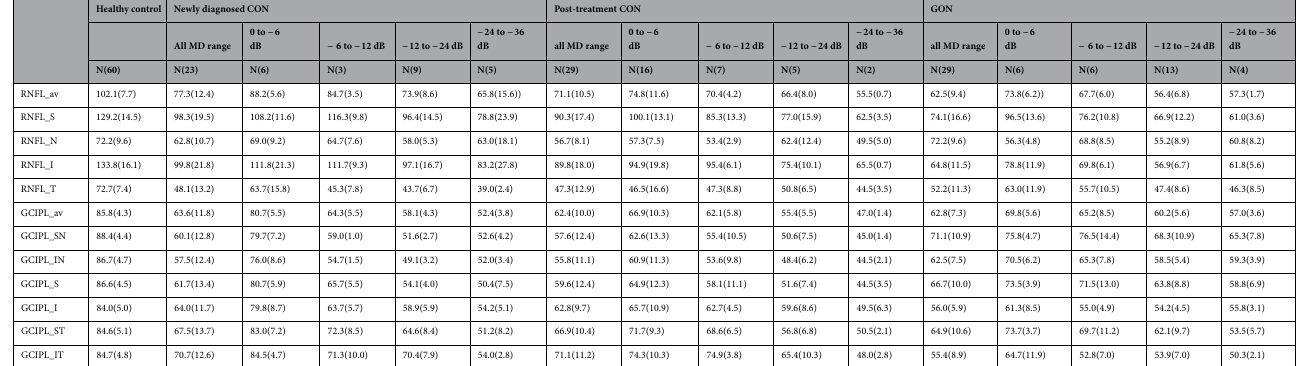
Twenty-three of the 34 newly diagnosed cases of CON with relatively more proportional structure and func- tion relationships, 29 GON eyes, and 60 healthy controls were stratified into 4 categories of − 6 dB MD decre- mental intervals. The mean thicknesses and standard deviations of each structural parameter for each group are detailed in Table 2. The amplitude and significance of the mean differences of each structural parameter for the different stages of CON and GON across the MD-loss range are listed in Table 3. The GON- and CON-specific